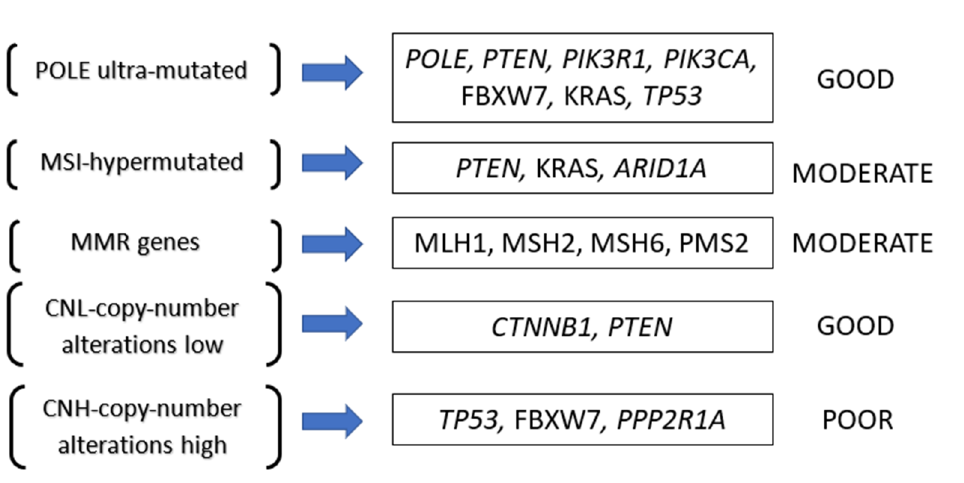
Figure 1. Prognostic categories as established by the Cancer Genome Atlas Research Network (CGARN).